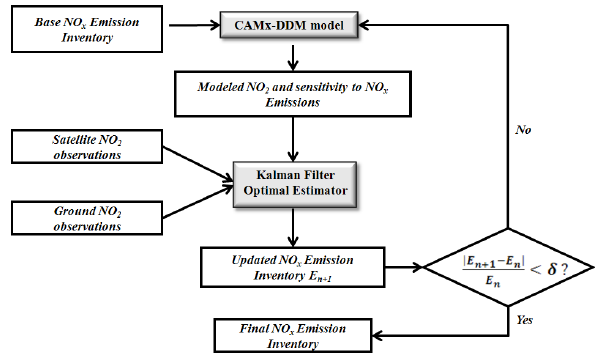
Fig. 2. Schematic diagram of Kalman filter inversion